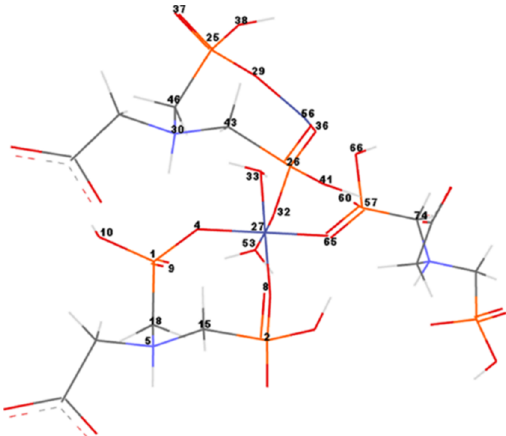
Figure 9. Co–Gly atoms numbering. For simplification only the numbers of significant atoms around the metal ions were represented. Table 5. Geometric properties of the Ni–Gly